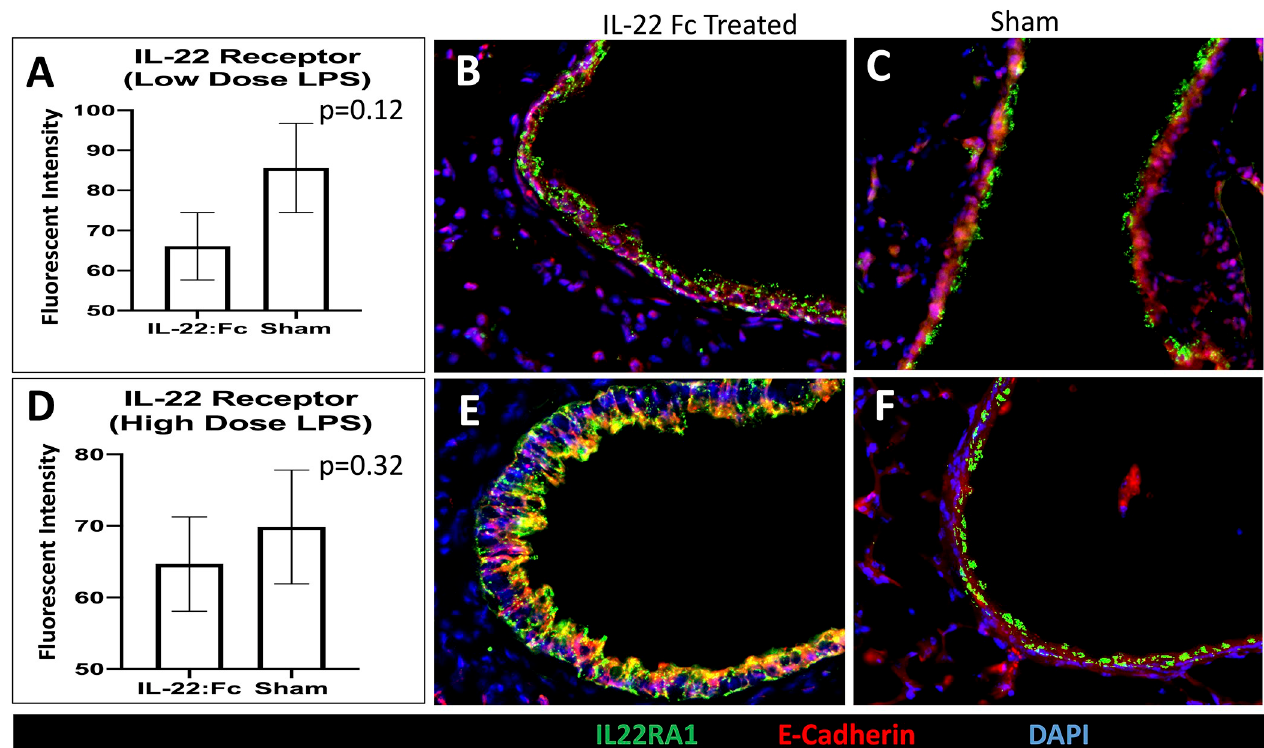
Fig 7. A comparison of the amount of IL-22 receptor in low- and high-dose LPS injured mice. The amount of IL-22Ra1 receptor was not different in the fk- 652 treated animals in both low- and high-dose LPS injury (A and D). Representative images of the airways are shown in low-dose LPS injured for B) IL-22:Fc treated and C) sham animals. Representative images of the alveoli is shown in high-dose LPS injured for B) IL-22:Fc treated and C) sham animals.